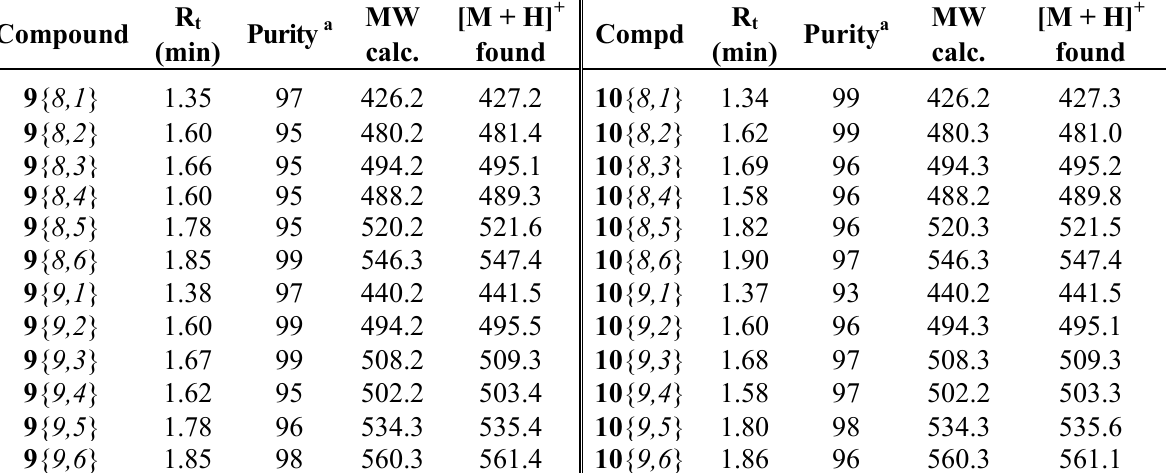
Table 3. Radioligand binding data of synthesized compounds for 5-HT